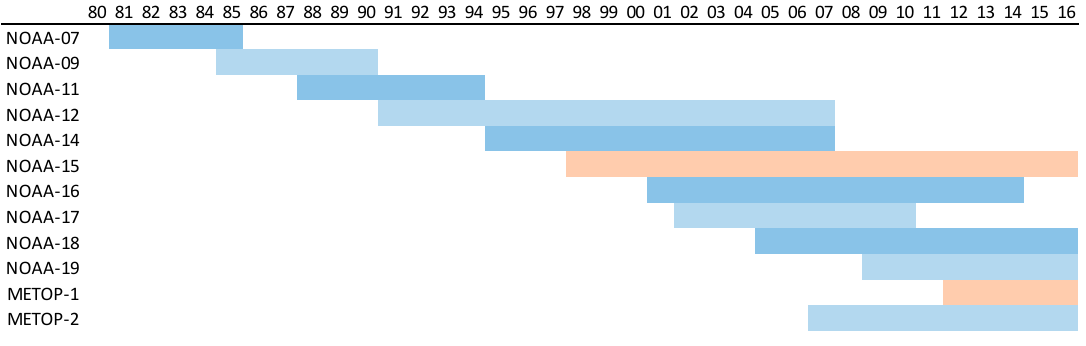
Figure 2. Availability of AVHRR data by platform and by years. In blue, the data that was used for the present study, and, in red, the data that was not processed due to the elevated amount of inconsistent data.